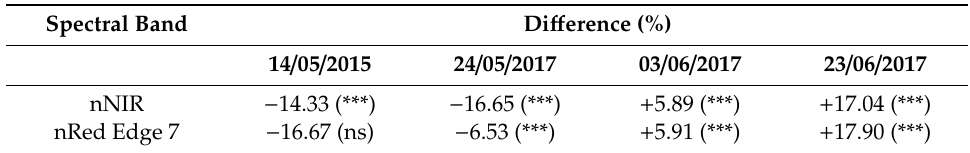
Table 6. Di ff erences in the relative reflectance of the normalized spectral bands computed in F compared to NF. Single asterisk indicates a significant di ff erence, p < 0.05; double asterisk indicates a statistical di ff erence, p < 0.01; triple asterisk indicates a statistical di ff erence, p < 0.001 (unpaired t -test). Spectral Band Di ff erence (%) 14 / 05 / 2015 24 / 05 / 2017 nNIR +17.04 (***) nRed Edge 7 + 5.91 (***) + 17.90 (***)